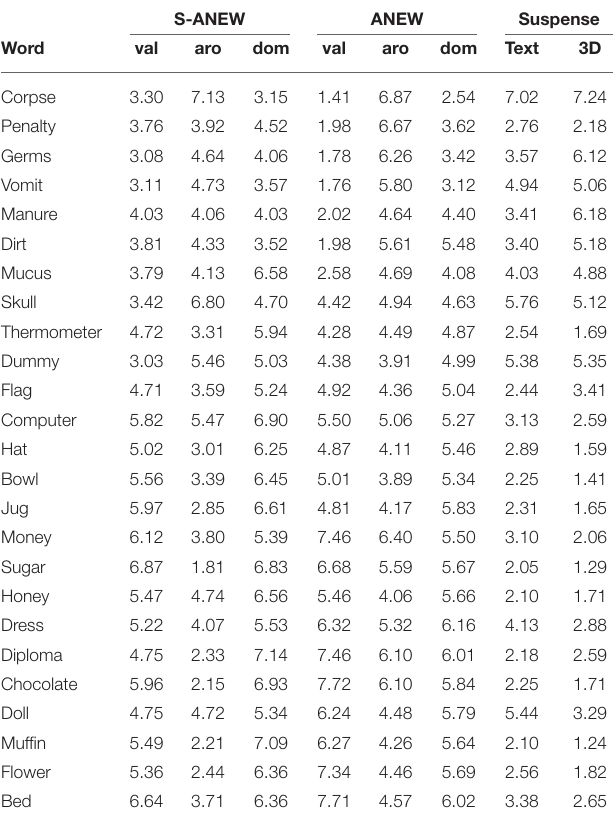
TABLE 8 | Means and medians of suspense perceptions for each object. S-ANEW ANEW